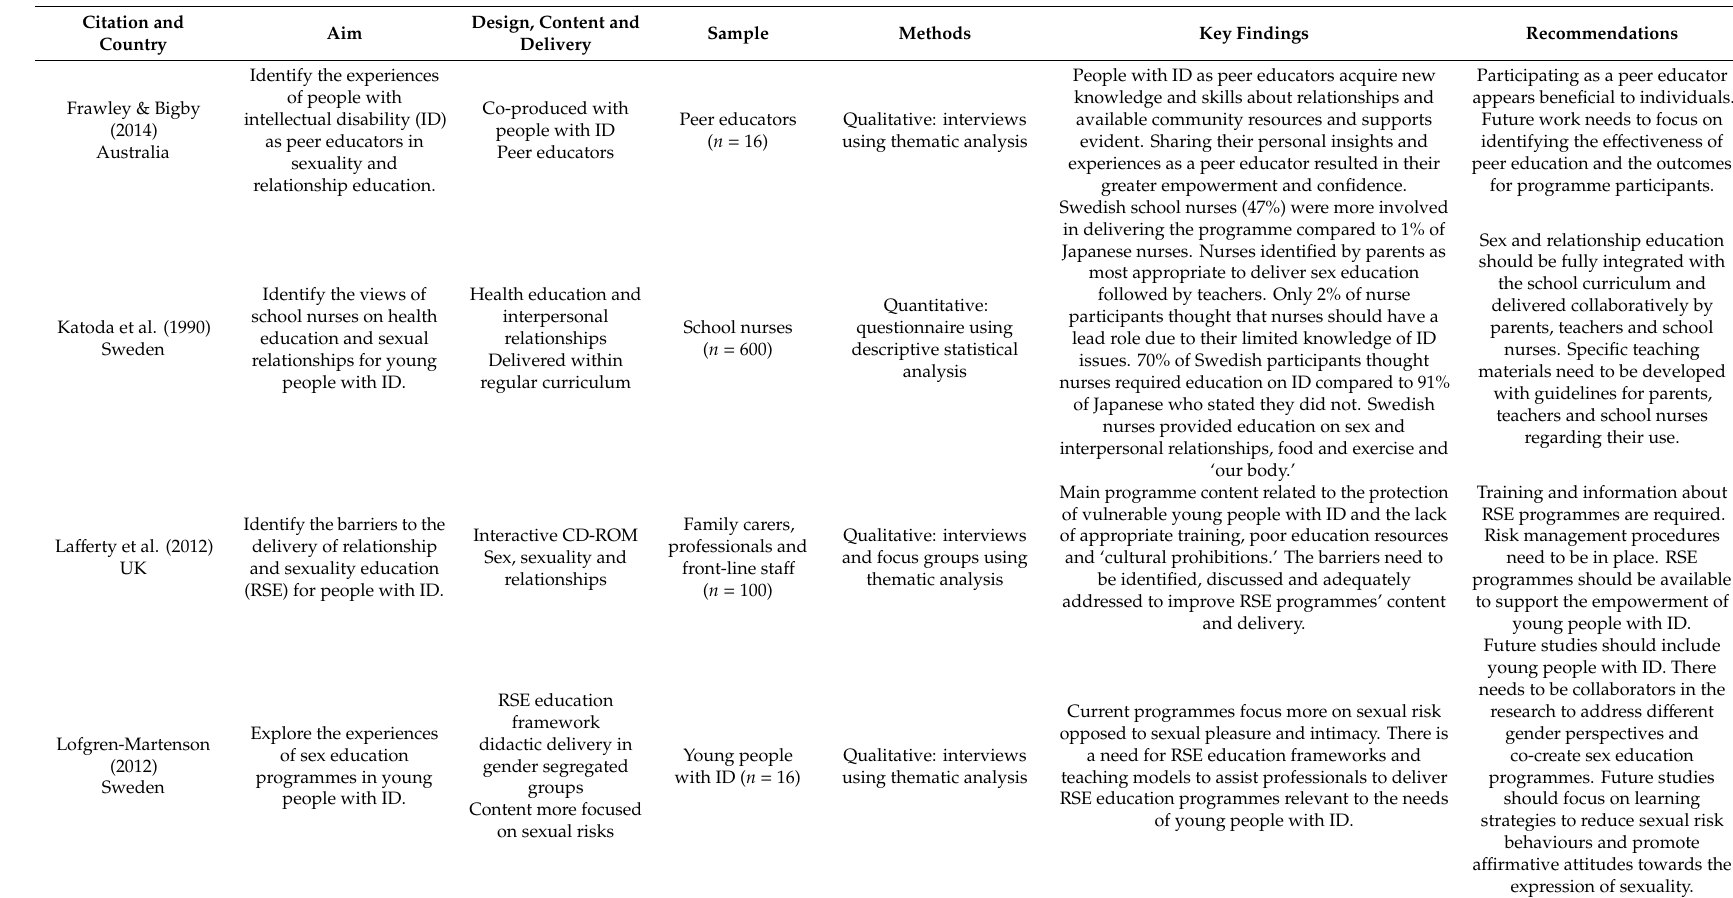
Table 3. Papers included in the review ( n =